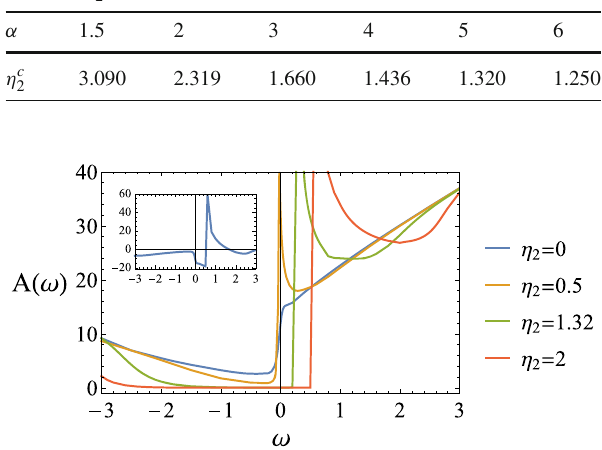
Fig. 5 A (ω) for different η 2 . Here, we have set α = 5 and T = 0 . 01. The inset shows A (ω,η 2 = 2 ) − A (ω,η 2 = 0 ) as a function of ω